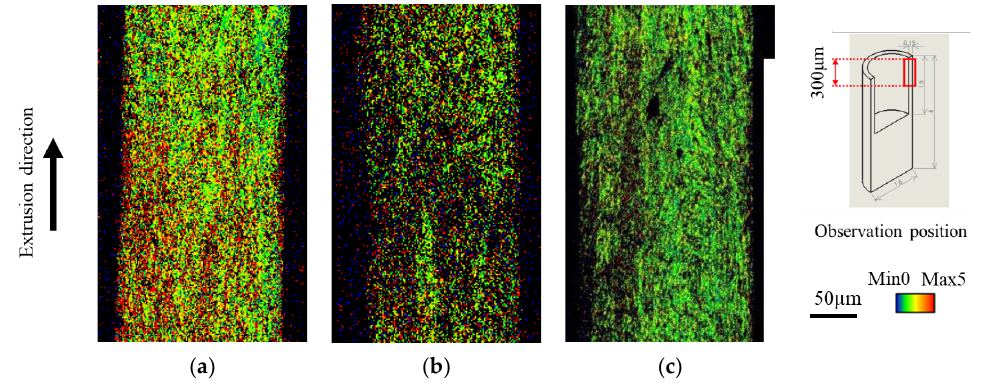
Figure 8. KAM map of the extrusion via EBSD: ( a ) mirror surface, ( b ) 5 μm -textured, and ( c ) na- nometer-textured punches.